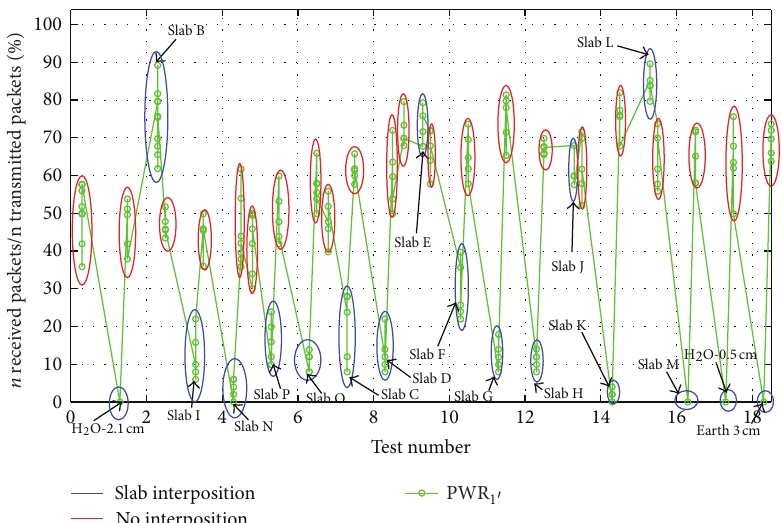
F 17: Reception ratio normalized to 100